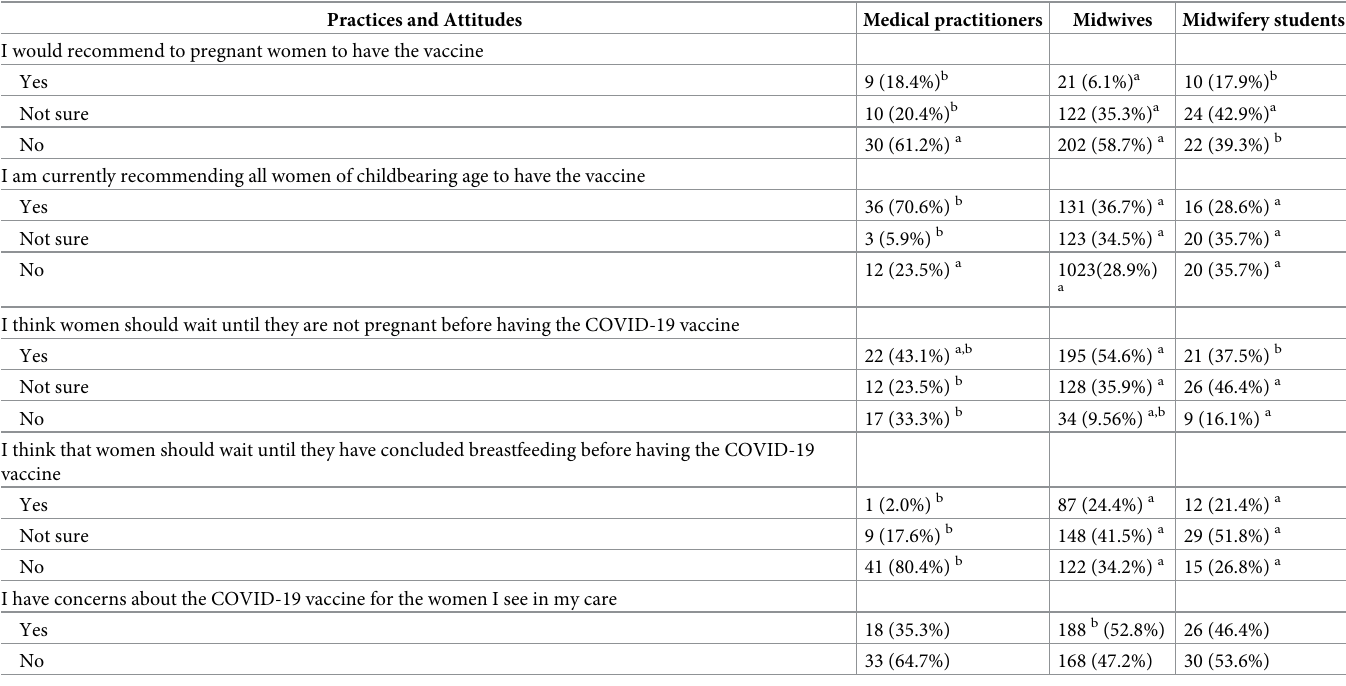
Table 5. Practices and attitudes regarding vaccination of women against